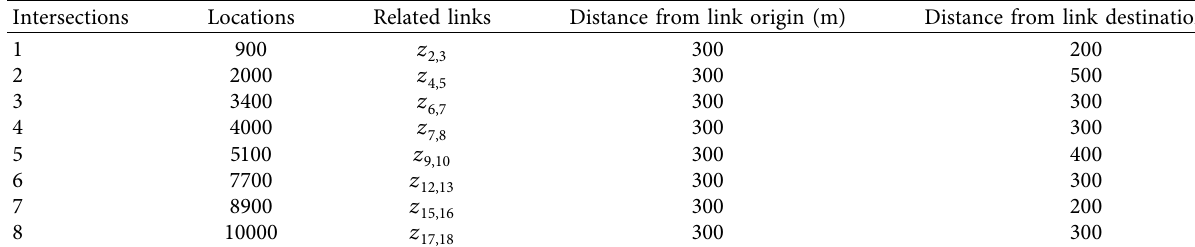
Table 2: Intersection information.